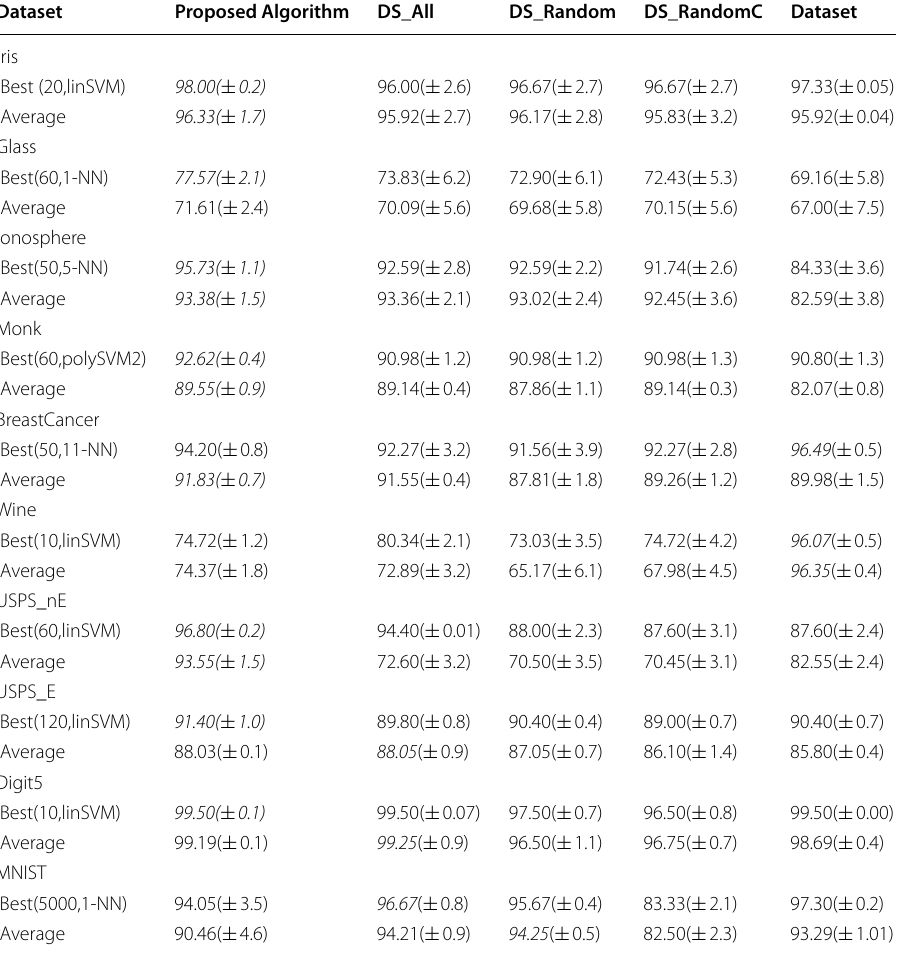
Table 5 Classification accuracy of the proposed method and other basic dissimilarity spaces ( standard ±